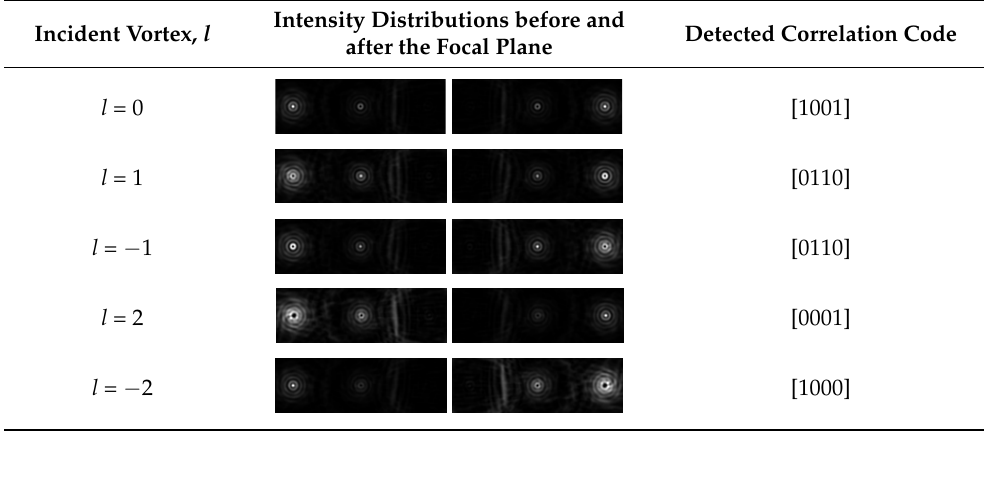
Table 2. Results of detection of vortex phase presence in the incident radiation with a cylindrical (radial or azimuthal) polarization state.